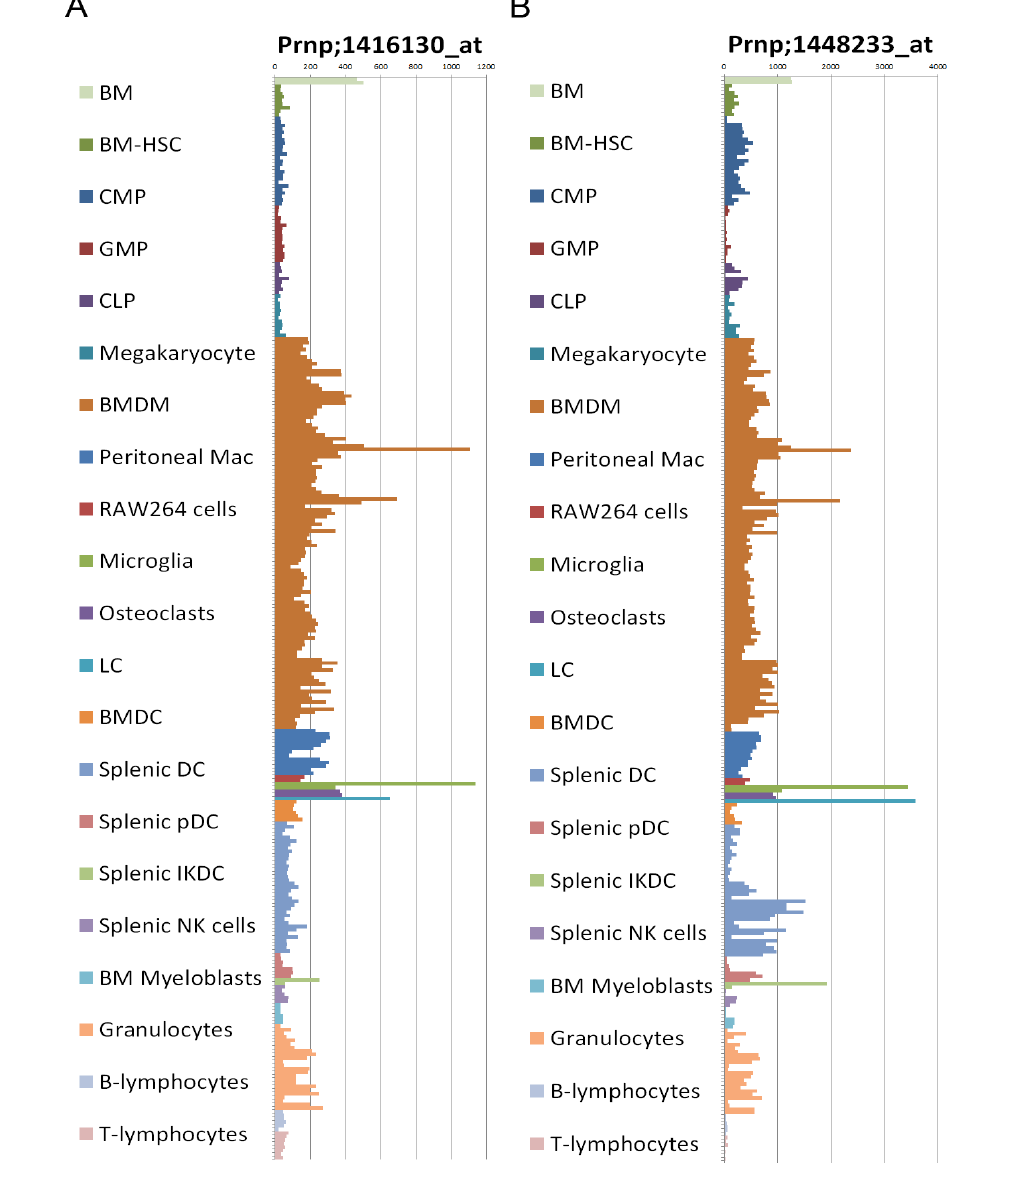
Figure 2. ( a ) Prnp expression profiling using Affymetrix GeneChip Mouse Genome 430 2.0 Array probesets 1416130_at and ( b ) 1448233_at; data from [176]. BM, bone marrow; HSC, hematopoietic stem cells; CMP, common myeloid progenitor; GMP, granulocyte- macrophage progenitor; CLP, common lymphoid progenitor; BMDM, bone marrow-derived macrophage; LC, Langerhans cell; BMDC, bone marrow-derived dendritic cell; DC, dendritic cell; pDC, plasmacytoid dendritic cell; IKDC, interferon-producing killer dendritic cell; NK, natural